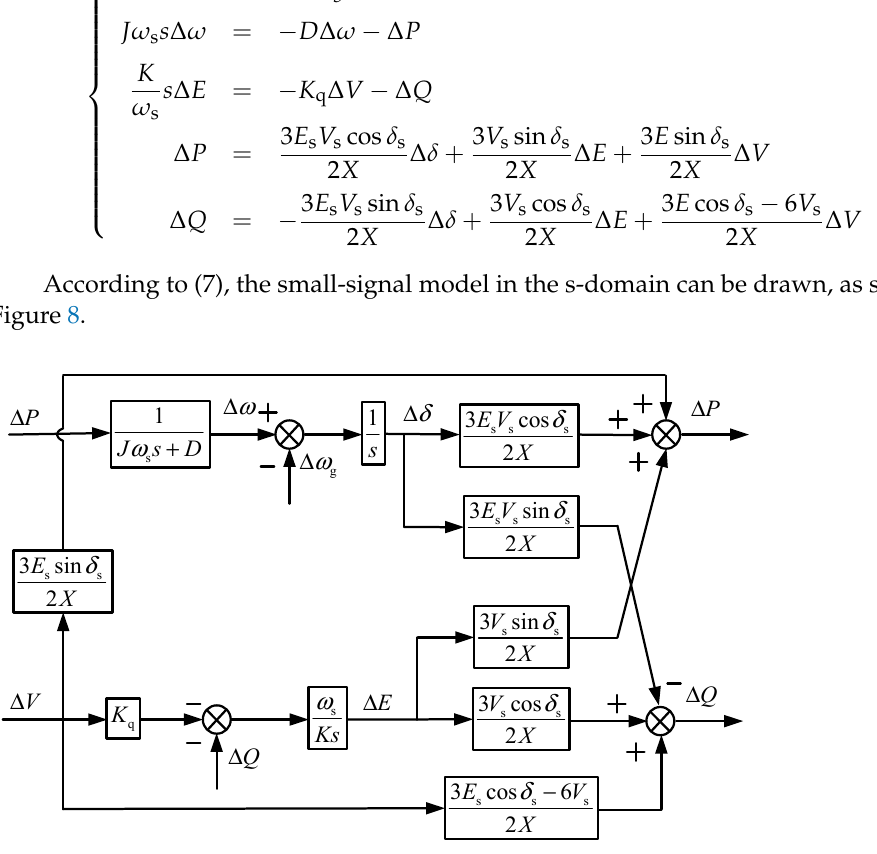
Figure 8. Small-signal modeling in response to changes in grid frequency.